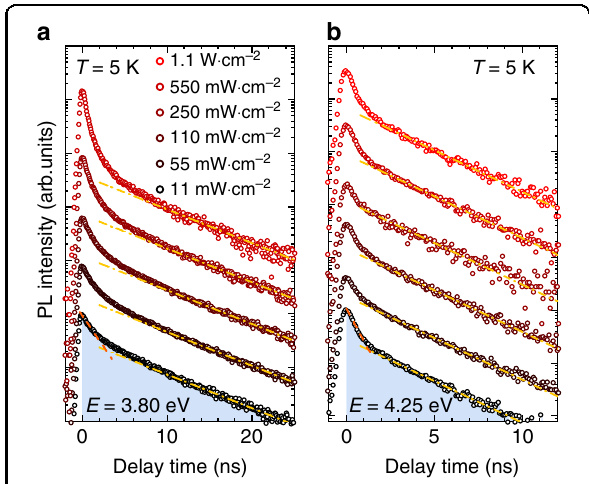
Fig. 8 Photoluminescence decays of GaN QDs recorded at 5 K. The transients are given for QDs emitting at a 3.80 eV and b 4.25 eV, for increasing excitation power densities. The tail of each transient is approximated by a single exponential with a τ decay value of 6.5 and 2.8 ns, respectively (yellow dash-dotted lines). At low excitation power density, the decay is bi-exponential. The fast decay component is also highlighted in the graph (orange dashed line). Noticeably, the discrepancy between the bi-exponential fi t and the experimental data increases with excitation power density. The channel resolution was reduced down to 80 ps/channel to improve the qualitative appraisal of decay time conservation. As an illustration, the fi lled areas correspond to the integrated intensity I tot collected at 11 mW cm − 2